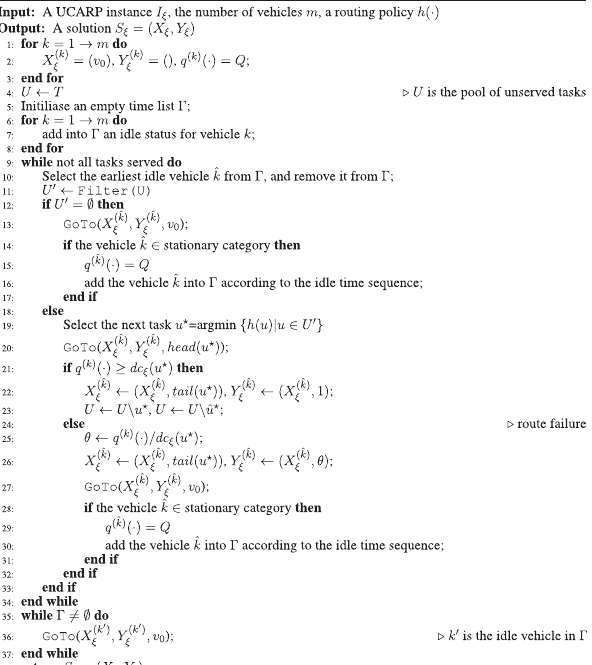
Algorithm 1. The proposed meta-algorithm of the GPHH for